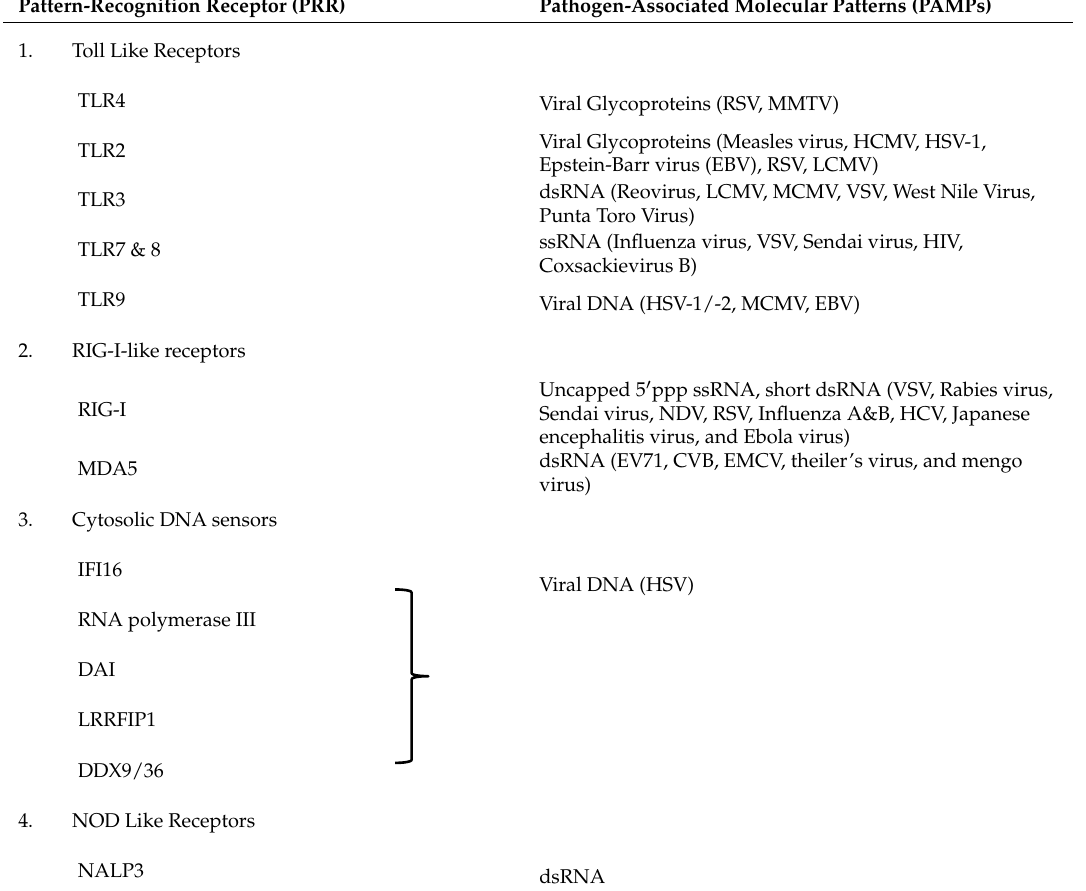
Table 1. Pattern-recognition receptors (PRRs) responsible for virus detection. Pattern-Recognition Receptor (PRR) Pathogen-Associated Molecular Patterns (PAMPs)